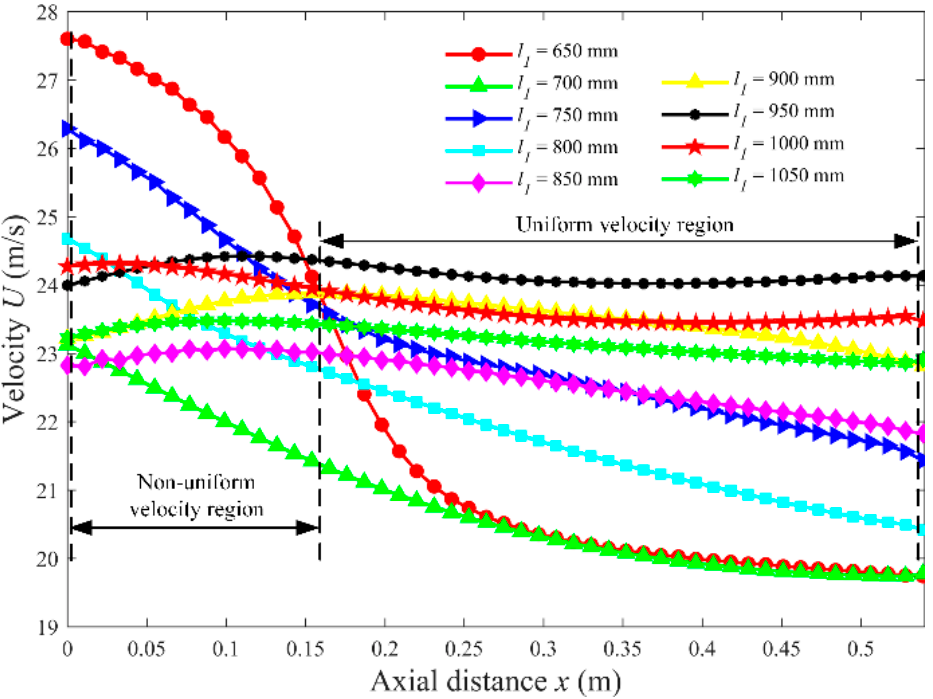
Figure 3. Velocity distribution characteristics at different diffuser lengths.